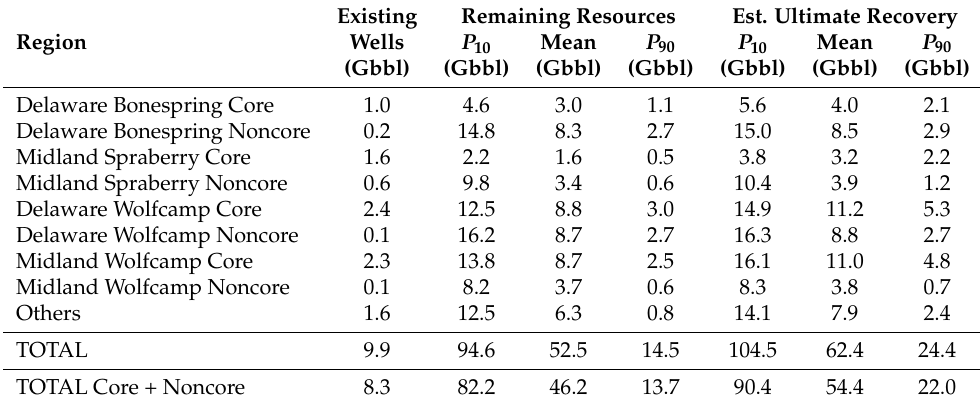
Table 6. Summary of natural gas resources in the Permian tight reservoirs.